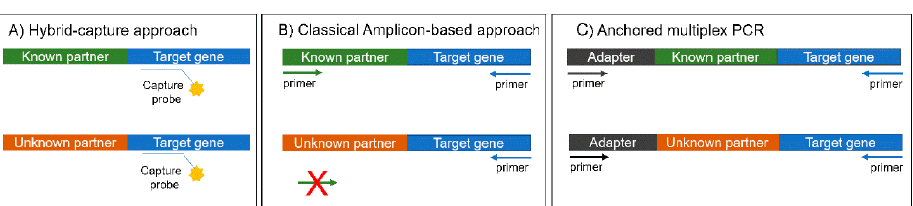
Figure 1. Schematic representation of the main NGS targeted approaches for gene fusion testing. ( A ) Hybrid-capture: gene-specific enrichment by a hybridization step with biotinylated DNA or RNA probes specific for the regions of interest: ( B ) Classical amplicon-based approach: target enrichment by a multiplex PCR using fusion variant specific primers; ( C ) Anchored Multiplex PCR: only one fusion partner needs to be targeted. Briefly, an NGS adapter is ligated to cDNA fragments, target enrichment is based on the amplification between gene-specific primers and a primer to the Table 1. NGS Targeted Approaches for Gene Fusion Analysis.